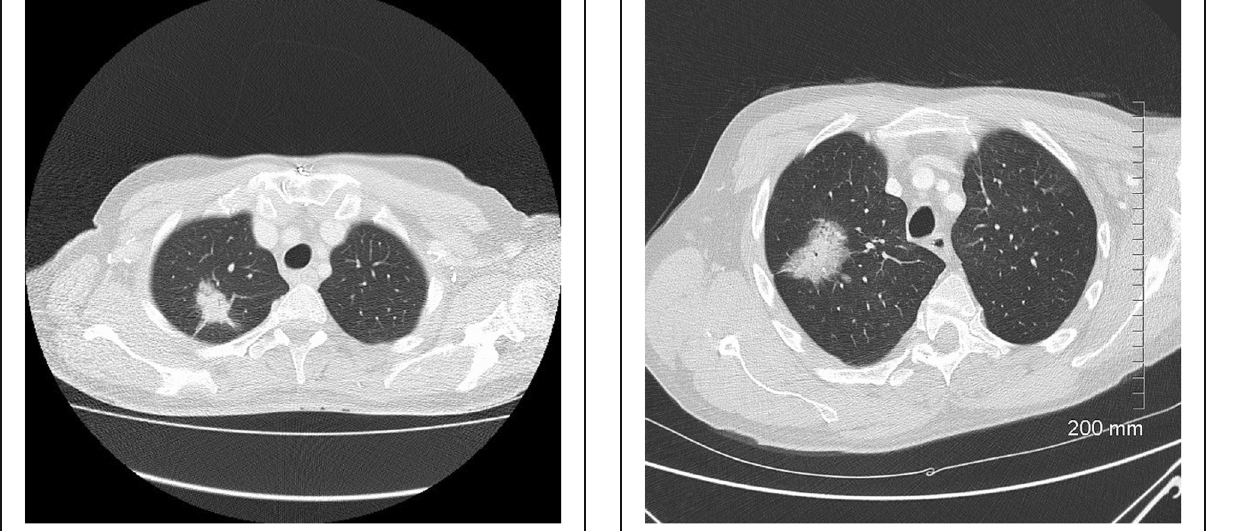
Fig. 8 Lepidic predominant adenocarcinoma on CT: 3.2 cm predominantly solid mass in the right upper lobe with air bronchograms, thick spiculations and pleural tethering